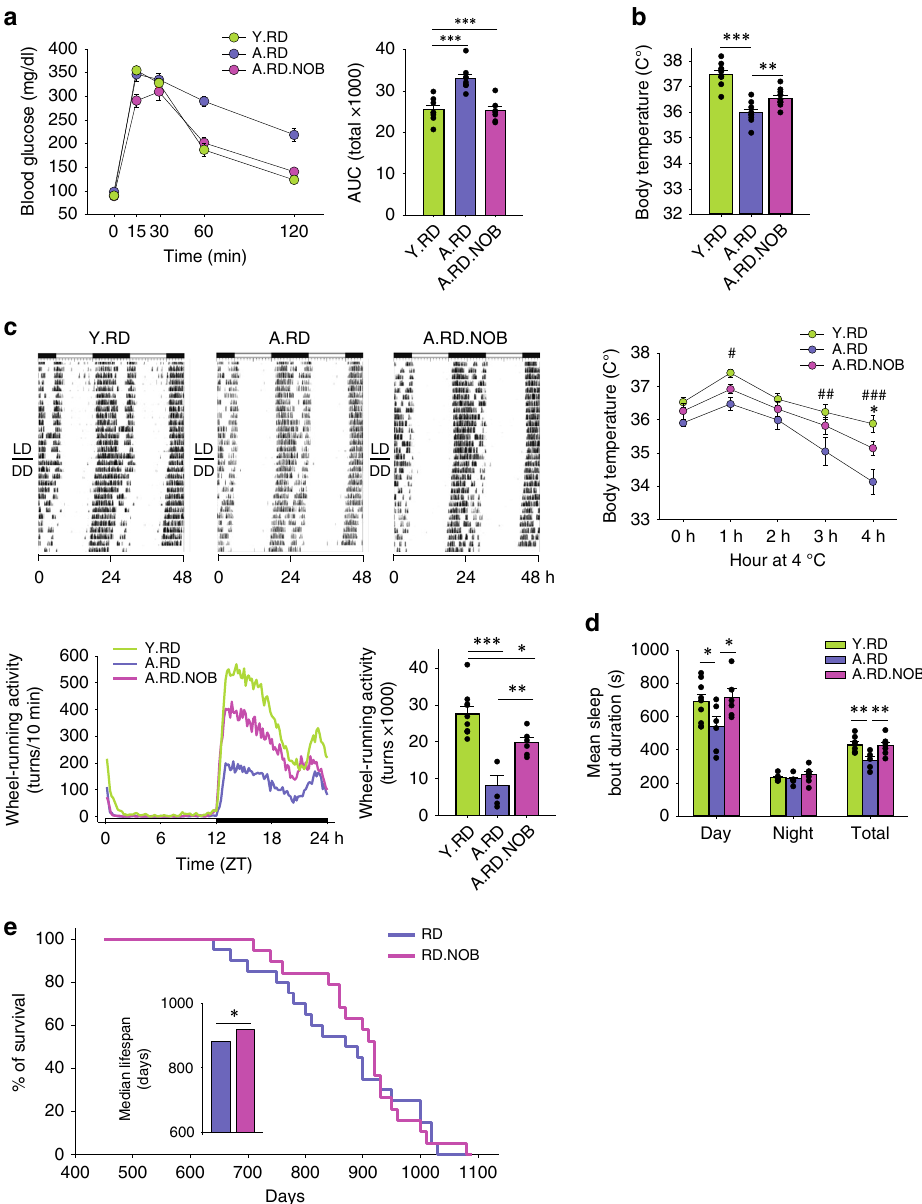
Fig. 1 NOB improved physiological health and survival of aged mice under regular diet. a – d Young (Y) or aged (A) mice were fed with regular diet (RD) or regular diet with NOB (RD.N). a Glucose tolerance test and area under curve (AUC) ( n = 10, 7, and 8 for Y.RD, A.RD, and A.RD.NOB, respectively). b Core body temperature (upper panel, n = 10) and cold tolerance (lower panel, n = 10, 7, and 5 for Y.RD, A.RD, and A.RD.NOB, respectively); *A.RD vs. A.RD. NOB; #A.RD vs. Y.RD; two-way ANOVA). c Wheel-running activity (WRA) analysis. Representative actograms (upper panels) are shown. Daily activity patterns (lower left, line graph) and daily averages (lower right, bar graph) are shown (ActiView) ( n = 10, 5, and 6 for Y.RD, A.RD, and A.RD.NOB, respectively). d Mean sleep bout duration was analyzed with the PIEZO sleep analysis system ( n = 9, 6, and 6 for Y.RD, A.RD, and A.RD.NOB, respectively). e Kaplan – Meier (KM) survival curves in 16-month-old mice fed with regular diet with or without 0.1% NOB supplement. Inset: median lifespan comparison. a – d * p < 0.05, ** p < 0.01, *** p < 0.001, one-way ANOVA. e * p < 0.05, Log-rank and Mann – Whitney U -tests (see Supplementary Fig. 1h). Data are presented as mean ± SEM in bar and line